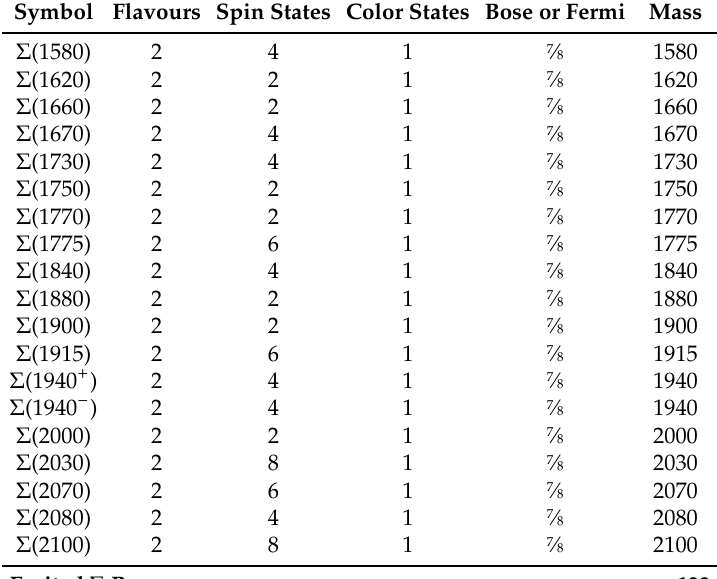
Table D6. Excited Σ baryons.